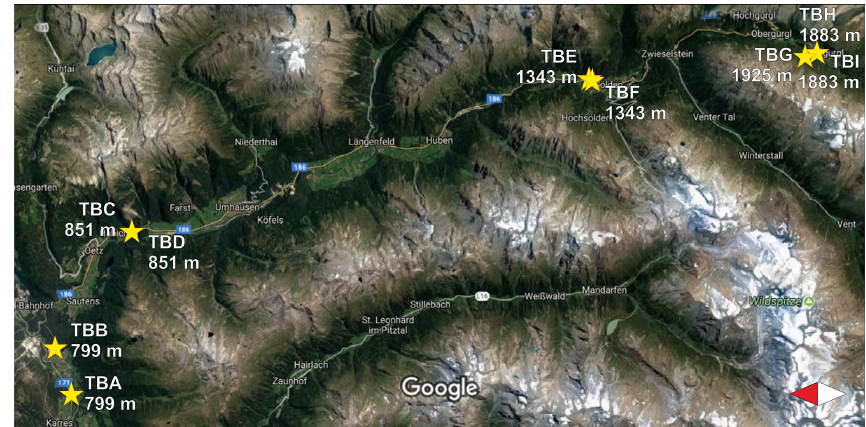
Figure 1. Sampling sites in Tyrol along a valley with an altitudinal gradient (adapted from Google Maps, https://www.google.com/maps, last access: 18 September 2017). Markings for TBH and TBI, as well as for TBC and TBD, completely overlap each other due to the close proximity of their growing